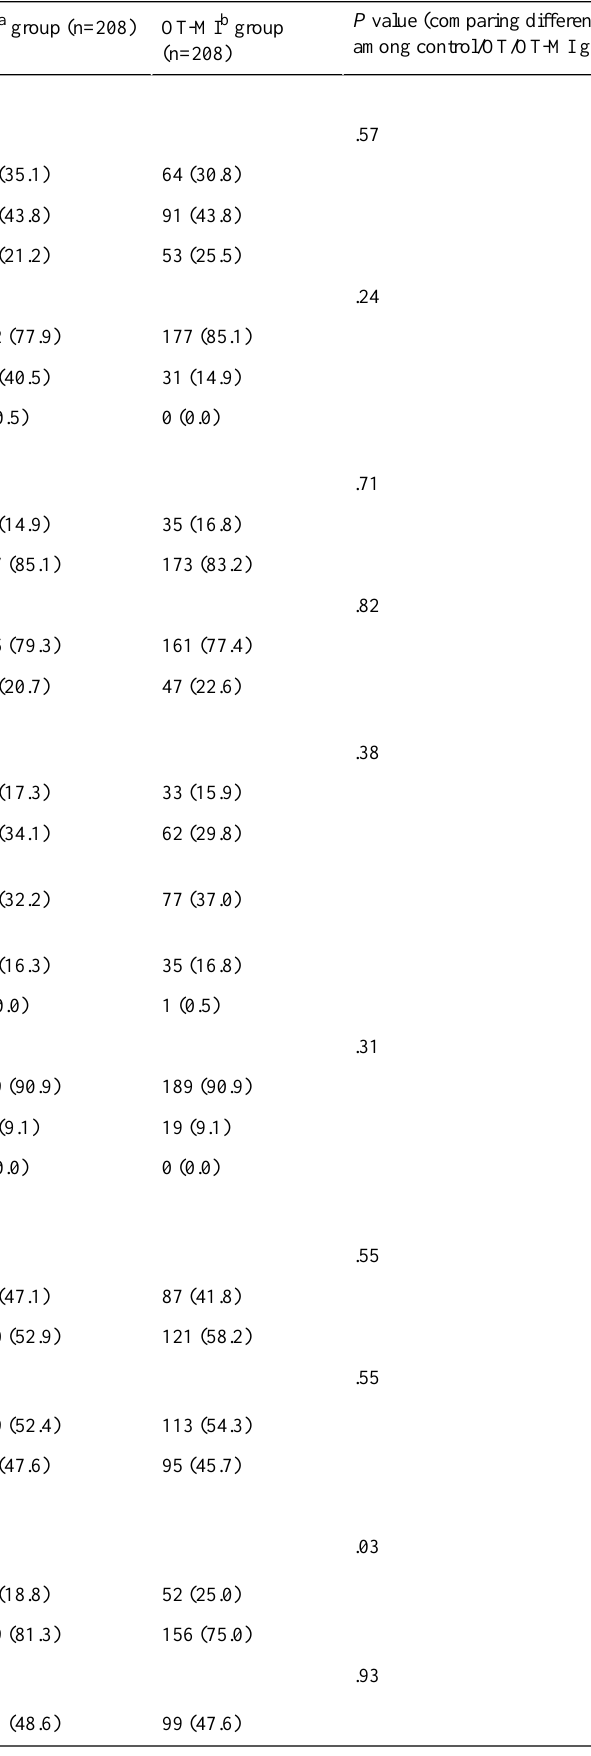
Table 1. Characteristics of participants at baseline.